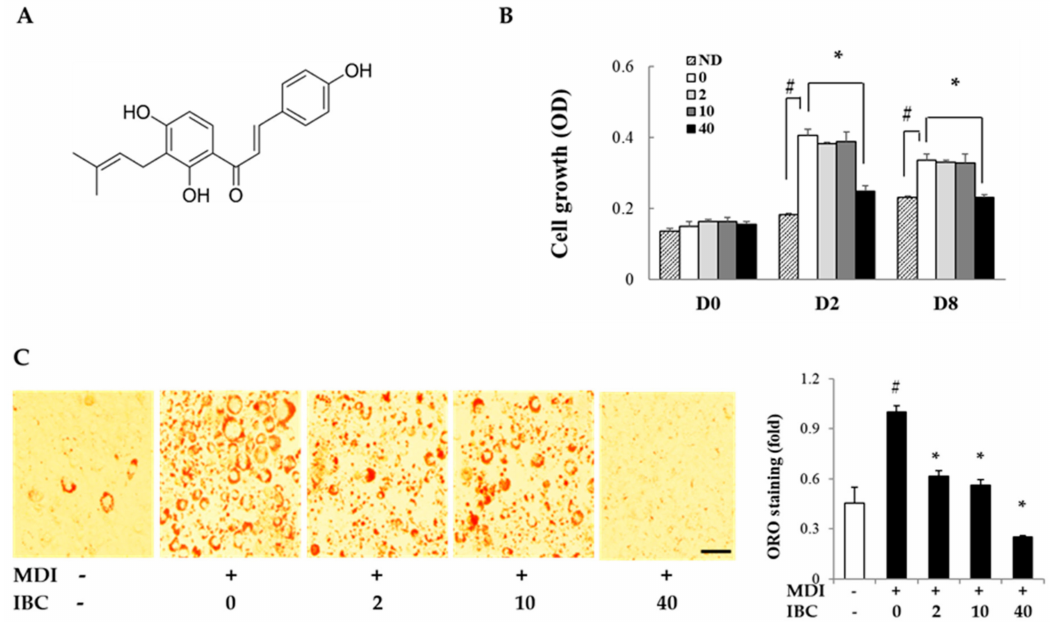
Figure 1. Structure of isobavachalcone (IBC) and effect of IBC on adipocyte growth and differentiation. ( A ) Structure of IBC isolated from A. keiskei (AK); ( B ) 3T3-L1 preadipocytes were differentiated with differentiation medium (MDI) in the presence or absence of IBC (0, 2, 10, or 40 µ M). On differentiation day 0, 2, or 8 (D0, D2, or D8), cells were subjected to MTT assay; and ( C ) 3T3-L1 cells were differentiated with IBC at indicated concentration. Cells were stained with Oil Red O (ORO) on D8, and intracellular lipid contents were quantified as described in Materials and Methods. Adipocytes stained with ORO (magnification, 40 × ) were visualized by light microscopy. Scale bar = 100 µ m. Data are means ± standard deviation (SD) of triplicate experiments. # p < 0.01 vs. control (no differentiation, ND); * p < 0.01 vs. MDI